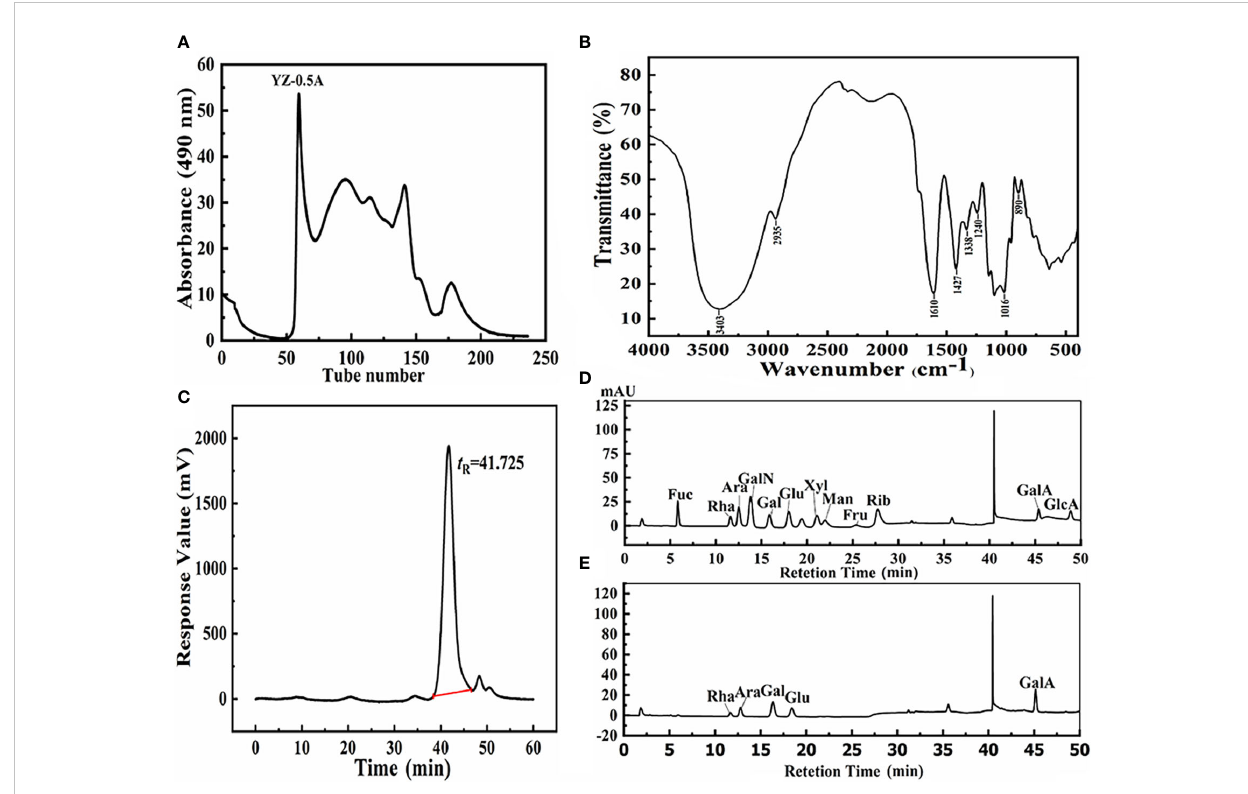
FIGURE 1 Structural information of YZ0.5-A isolated from pomelo fruitlets. (A) Gel permeation chromatogram using a Sephadex G-200 column; (B) FT-IR spectra of YZ0.5-A; (C) HPGPC of YZ0.5-A; (D) HPAEC of monosaccharide standards; (E) HPAEC of